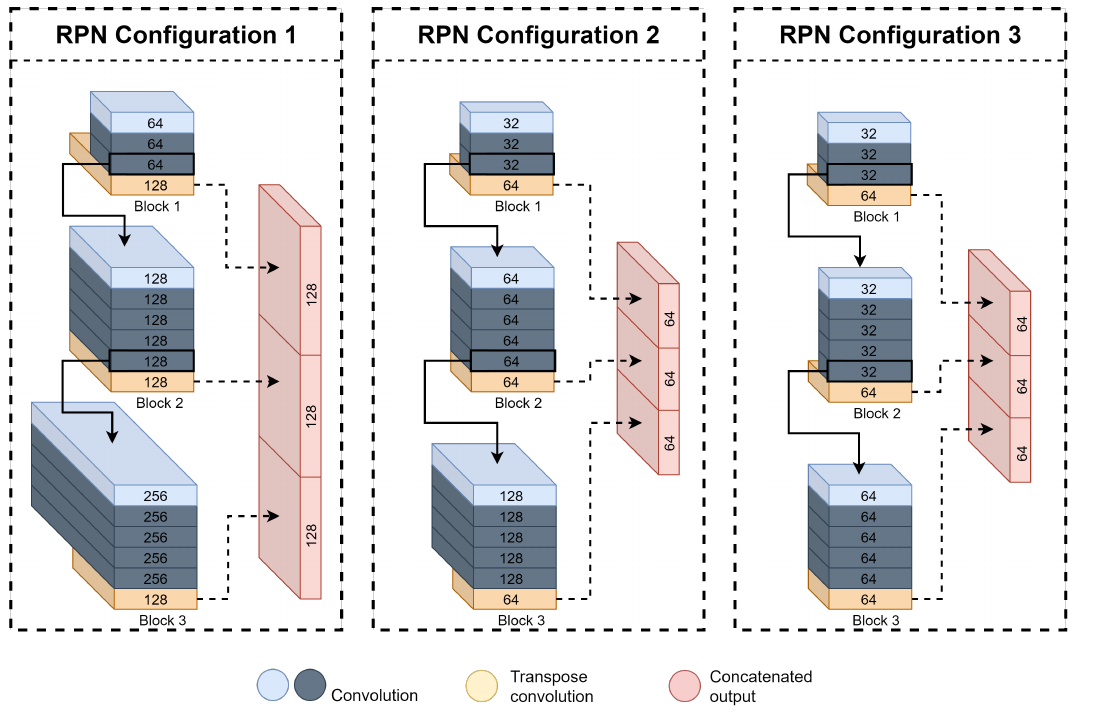
Figure 7. RPN configurations structure overview. Table 11. The set of network configurations